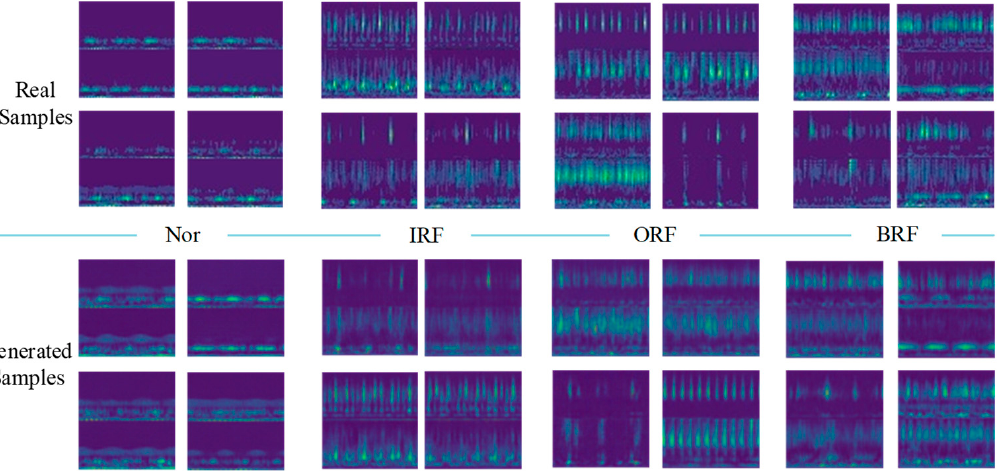
Figure 14. Comparison between the real samples and the generated samples with CWRU dataset. Table 5. Experimental setup and results for evaluation of the generated samples.